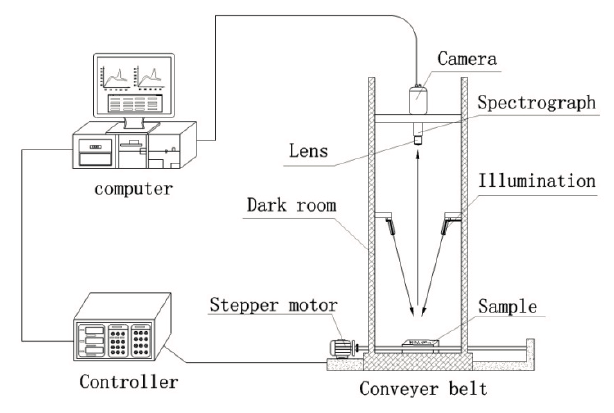
Figure 1. The schematic diagram of the hyperspectral imaging